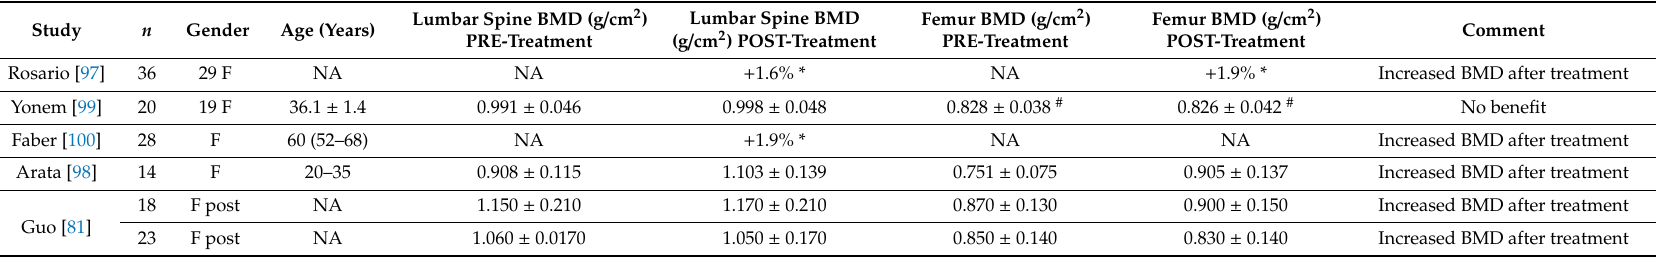
Table 6. Studies that analyzed the e ff ect of the treatment of subclinical hyperthyroidism on lumbar spine bone mass density and femoral bone mass